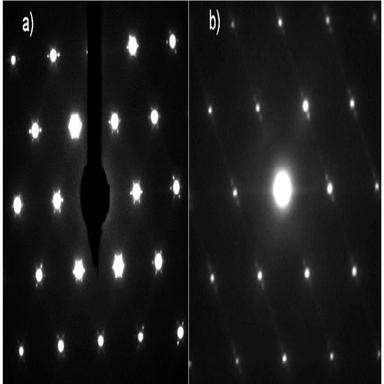
diffraction patterns from different compositions showing incommensurate modulations towards 110 directions. a) incommensurate modulations from 2:90:10 composition towards 2 different 110 directions. b) incommensurate modulations from a 4:90:10 towards a .